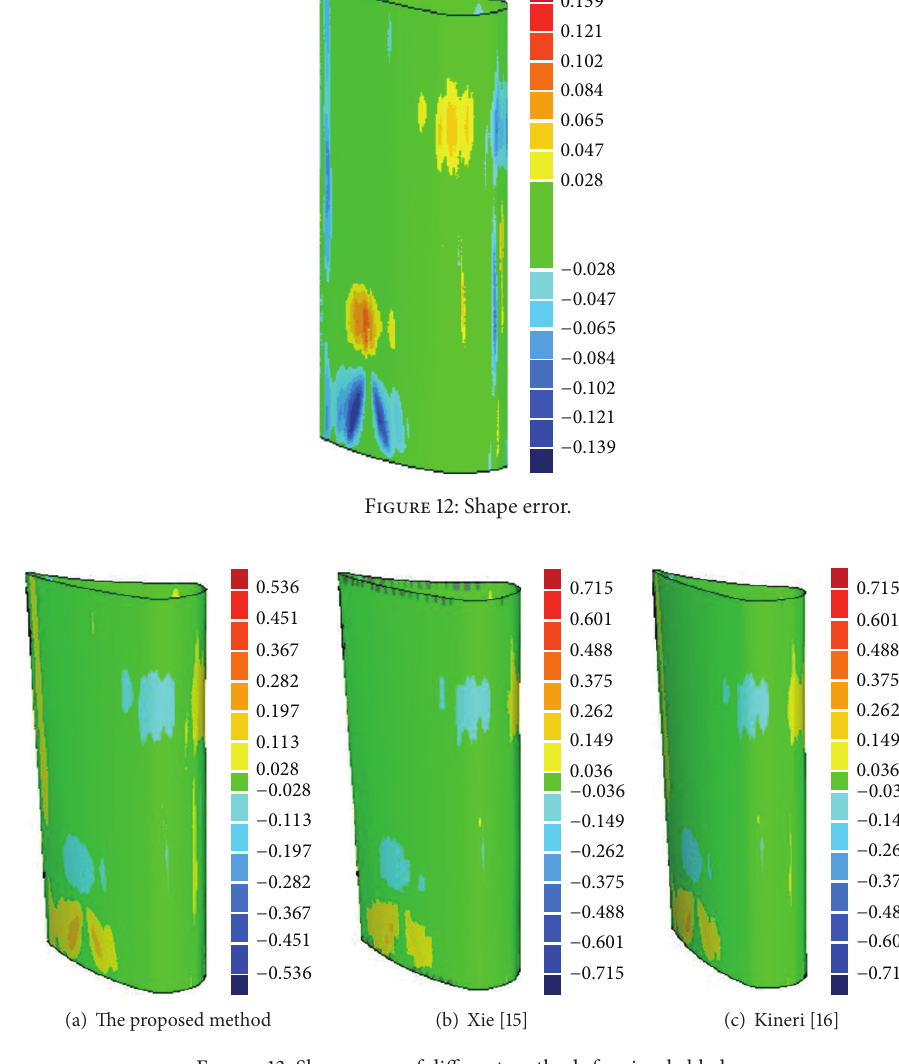
Figure 13: Shape error of different methods for simple